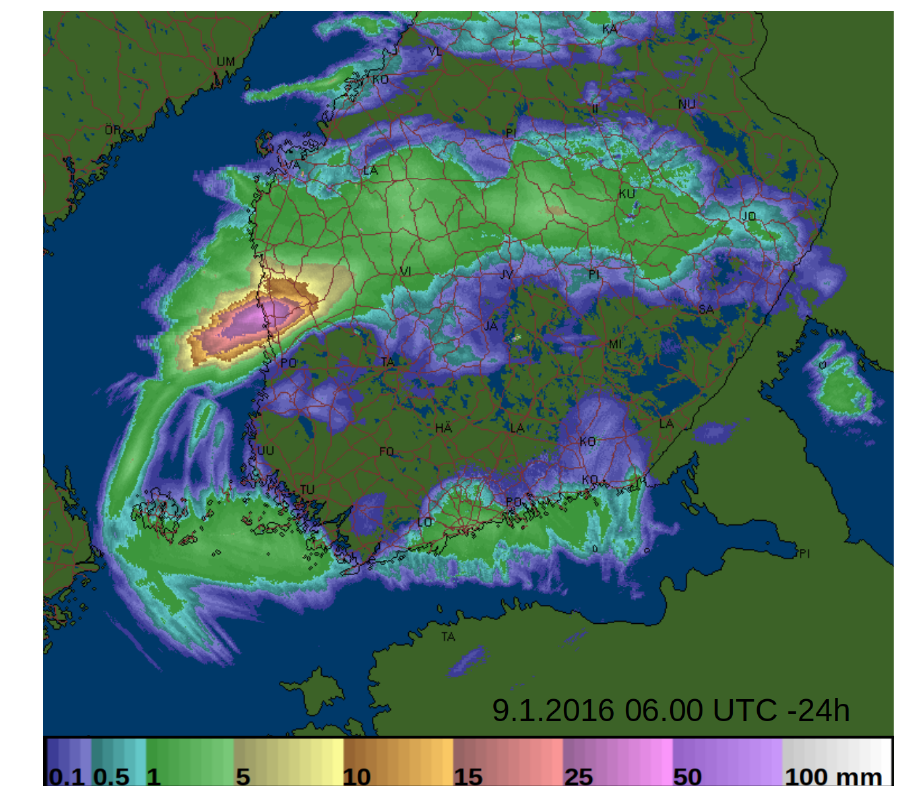
Figure 7. Radar image of precipitation accumulation (mmd − 1 ) between 8 January at 06:00UTC and 9 January 06:00UTC in 2016, at the time when the national Finnish record of 73cm of new snow in less than a day was measured in Merikarvia. The figure is sourced from the radar service of the FMI